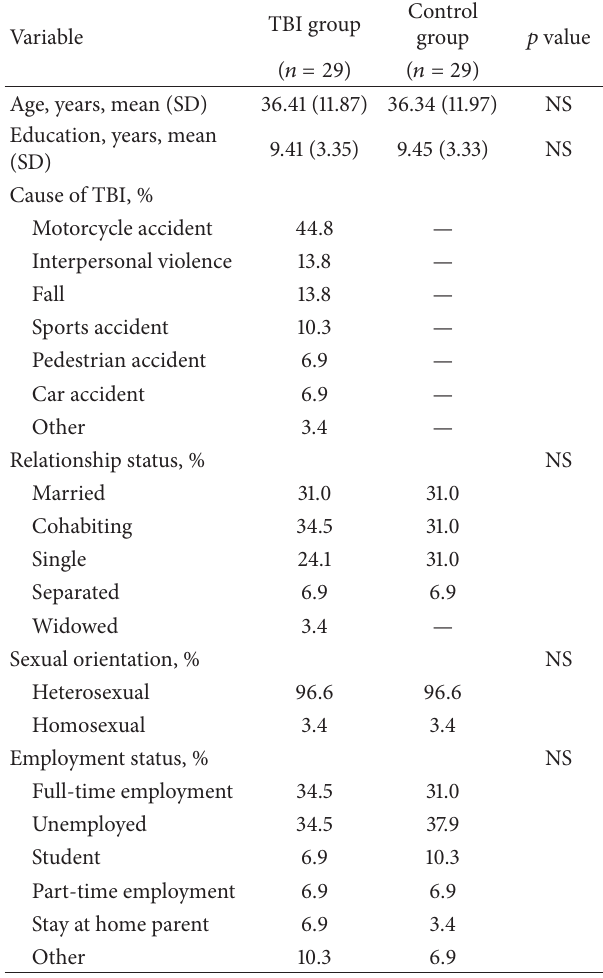
Table 1: Participant